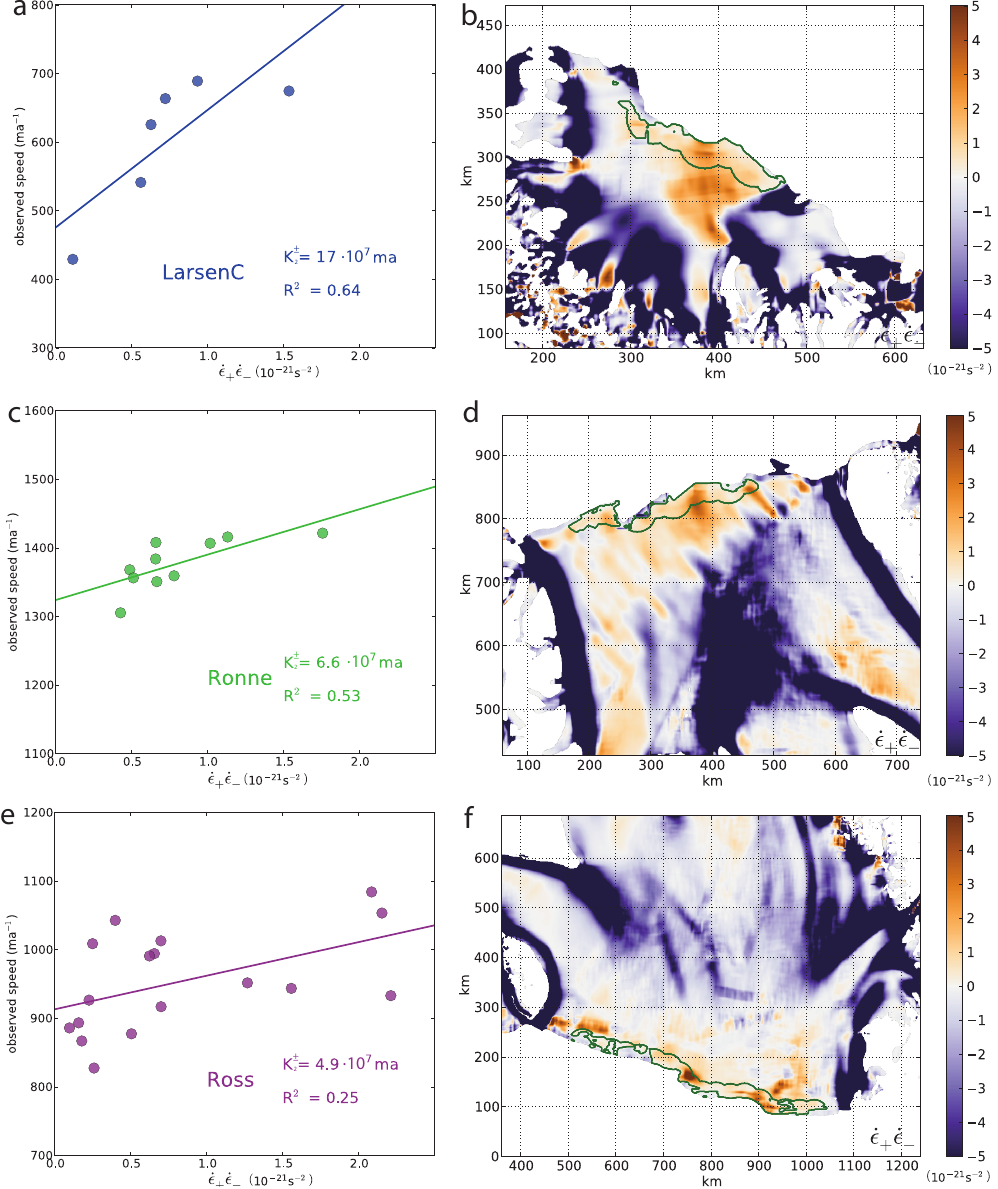
Fig. 3. Eigencalving relation for the comparably broad topographies of Larsen-, Ronne- and Ross-ice shelves as derived from the surface velocity data set by Rignot et al.